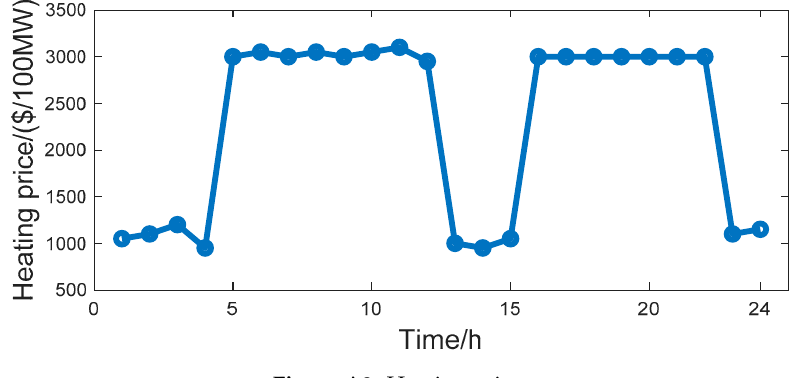
Figure A3. Heating price.